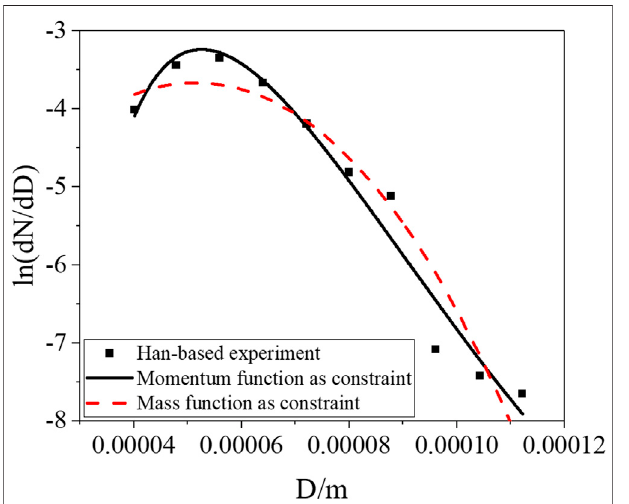
FIGURE 1 | Results of droplet size distribution of HAN-based liquid droplets under the pressure difference of 1.8 MPa.